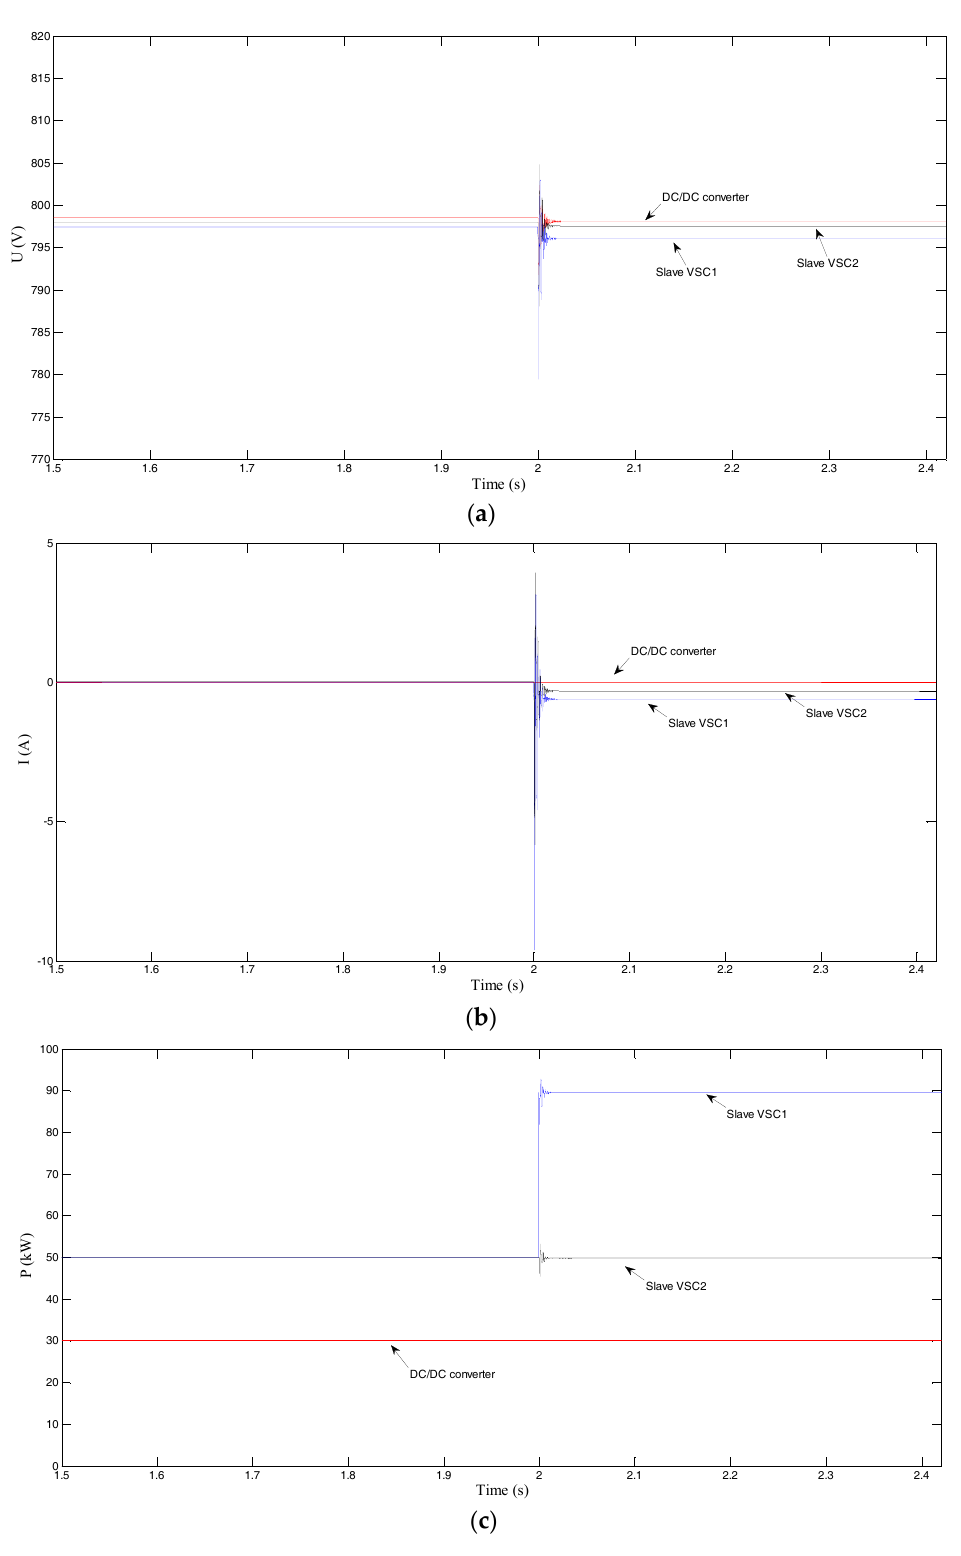
Figure 11. Simulation waveform by changing P s1 = 50 kW to P s1 = 90 kW at t = 2 s: ( a ) DC voltages; ( b ) active stabilization currents; and ( c ) active power.